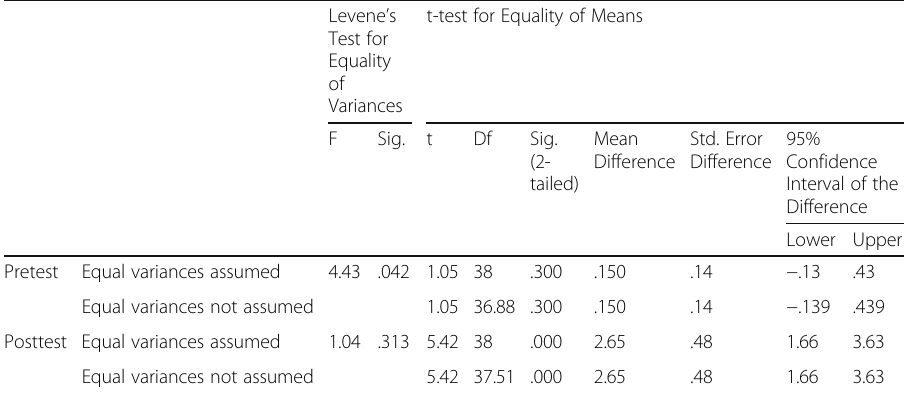
Levene ’ s t-test for Equality of Means Test for Equality of Variances F Sig. t Sig. Mean Std. Error 95% (2- Difference Difference Confidence tailed) Interval of the Difference Lower Upper